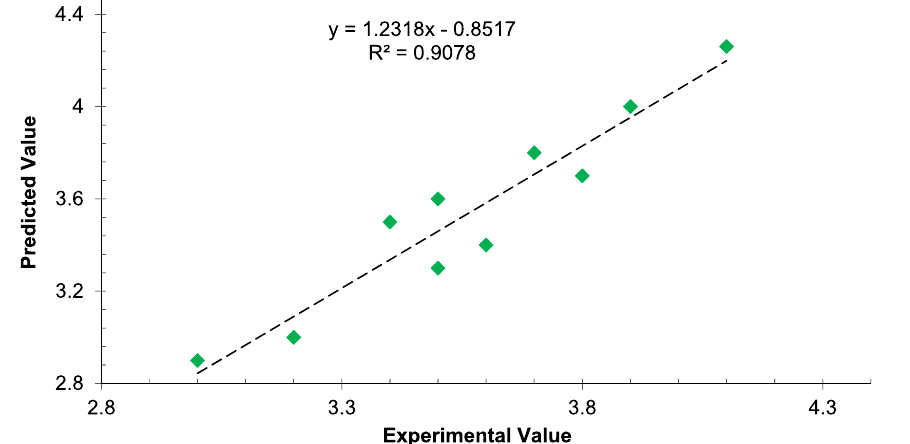
Figure 12. Correlation between predicted value and experimental value.